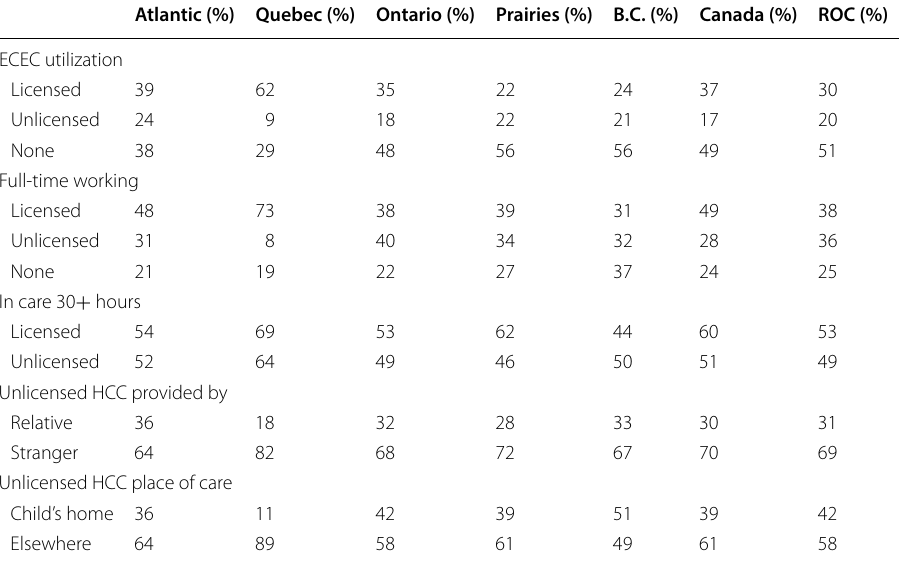
Table 2 Patterns of ECEC utilization across the regions of